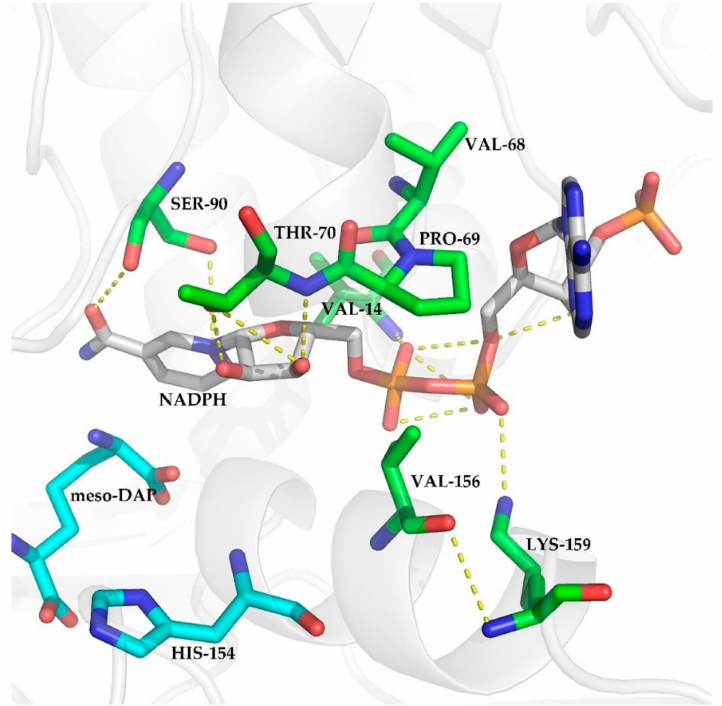
Figure 2. Polar contacts between NADP + and residues V14, V68, P69, T70, S90, V156, and